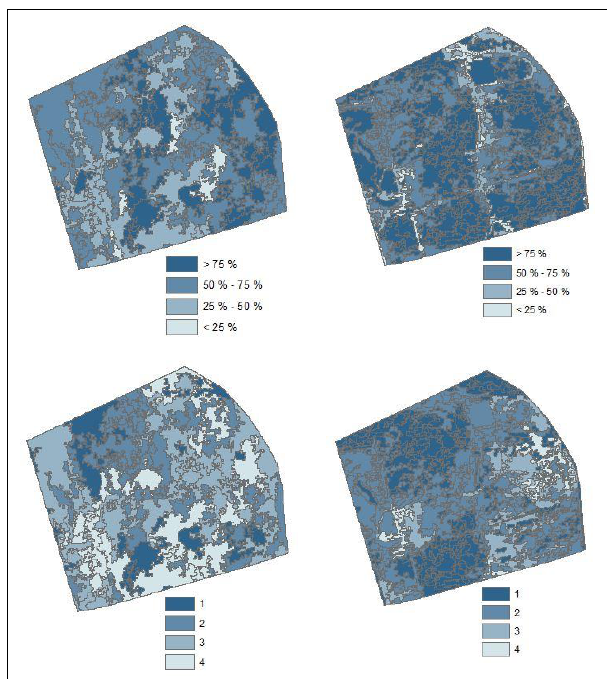
Figure 4. The quality map for the segmentation results on TS-X (left) and on WV-2 (right) imagery.